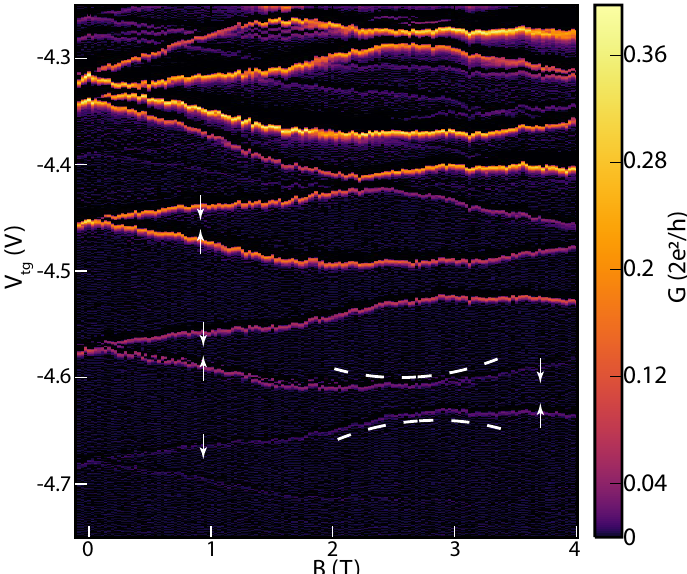
Figure 3: Differential conductance of device 1 as a function of topgate voltage and magnetic field. Arrows represent spin up and spin down states. Dashed curves illus- trate an anticrossing of opposite-spin states. Magnetic field is applied at an angle of 25 degrees with respect to the nanowire axis, in the substrate